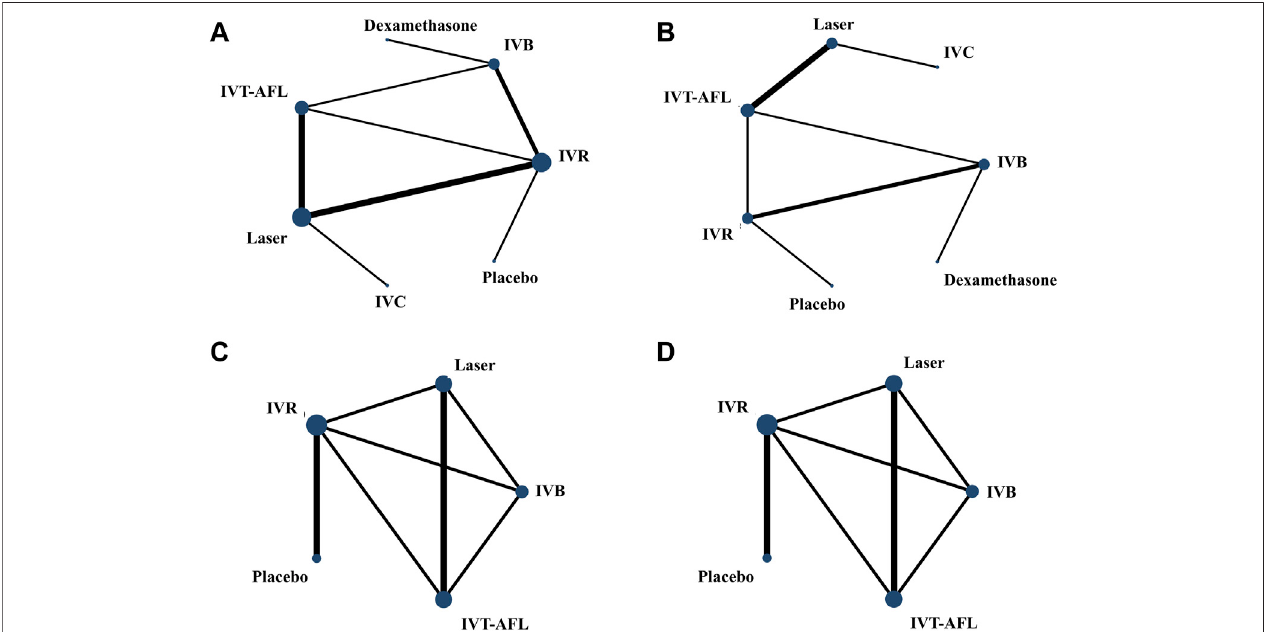
FIGURE 5 | Network geometry for the proportion of patients with at least 15 ETDRS letters. All populations at 1-year follow-up [ (A) 11 trials] and 2-year follow-up [ (C) 7 trials]. Population with worse baseline VA at 1-year follow-up [ (B) 8 trials] and 2-year follow-up [ (D) 7 trials]. ETDRS, Early Treatment Diabetic Retinopathy Study; IVB, intravitreal bevacizumab; IVC, intravitreal conbercept; IVR, intravitreal ranibizumab; IVT-AFL, intravitreal a fl ibercept. Notes: Direct comparisons are represented by the black lines connecting the different interventions. Line width is proportional to the number of trials including every pair of interventions, whereas circle size is proportional to the total number of trials for each intervention in the network.